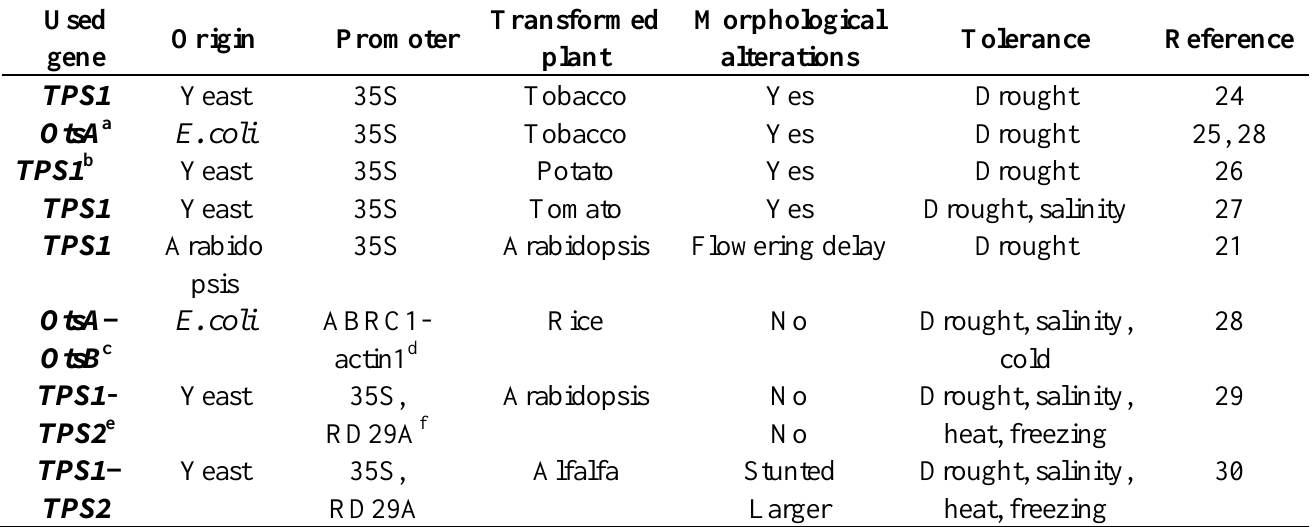
Table 1. Transgenic plants expressing trehalose biosynthetic